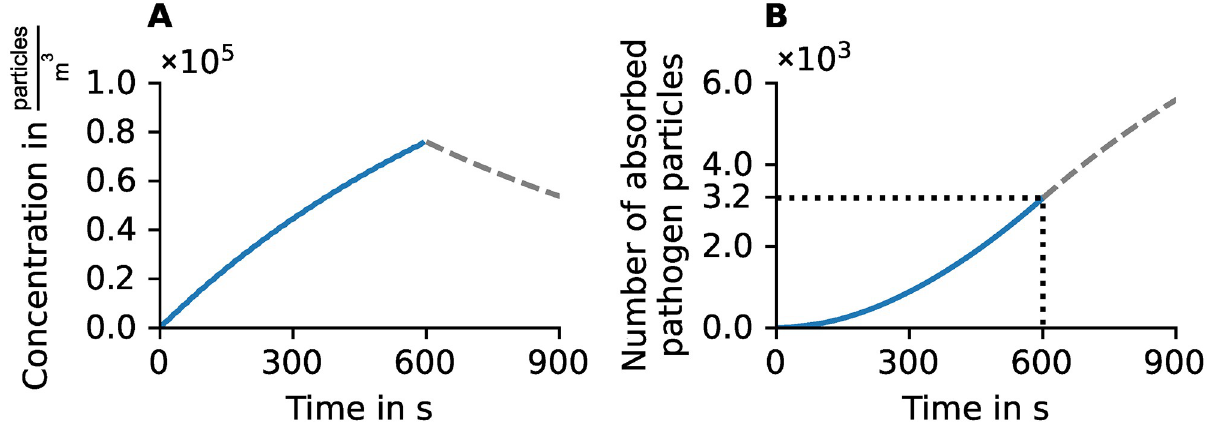
Fig 5. Pathogen concentration and absorption in the close contact scenario. An infectious person emits aerosol clouds so that the pathogen concentration builds up. The susceptible one absorbs approximately 3.2 � 10 3 pathogen particles within the critical period of 600 s (dotted lines). The dashed lines represent an extension of the scenario: The infectious person leaves at t = 600 s, whereas the susceptible person remains and keeps absorbing pathogen from the exponentially decaying aerosol clouds. A: Pathogen concentration of aerosol clouds adds up. B: Pathogen load absorbed by the susceptible